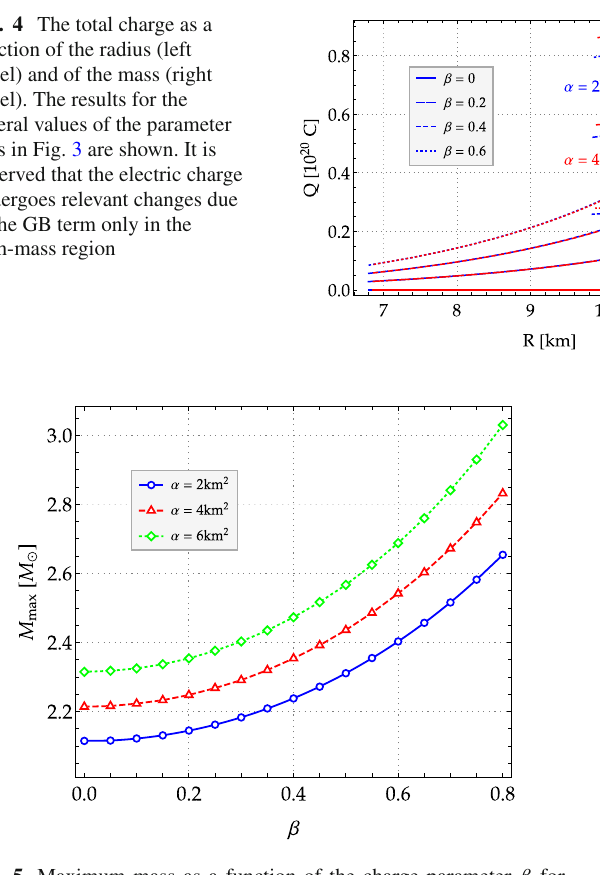
main effect of both parameters α and β on the maximum mass of charged quark stars can be better